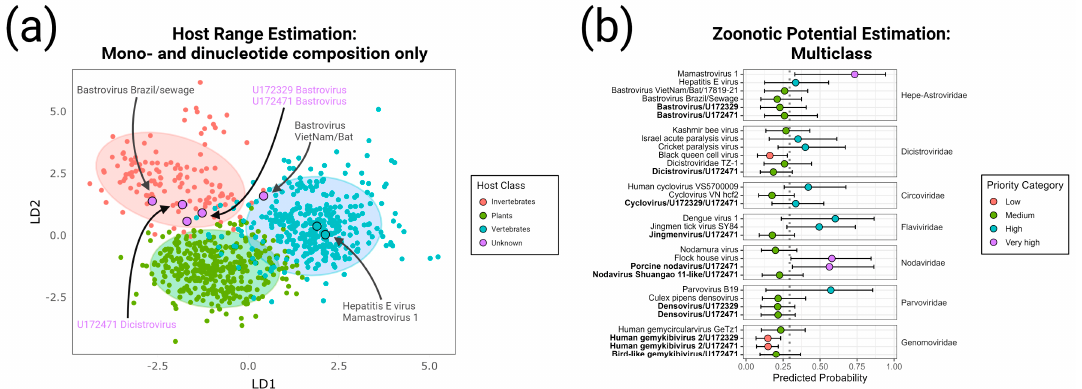
Figure 5. Assignment of host class and zoonotic potential. ( a ) The canonical score plot of a linear discriminant analysis used to classify picorna-like viral sequences into three host groups using all 4 mononucleotide and all 16 dinucleotide frequencies. The plot shows the separation of host groups through the two most statistically significant factors. The training dataset with known host range (n = 945 genomes) was used to establish a scoring profile such that the viral sequences with unknown host could be classified. The ellipses represent the 90% confidence level (i.e., 90% of sequences fitting a host range group fit inside the ellipsis) centered on the centroid of each group. Sequences from the bastroviruses from U172329 and U172471, the dicistrovirus from U172471, and four comparator sequences are labeled separately. ( b ) Predicted probability of human infectability for all novel viruses identified in this study and closely related comparator sequences. Dots show the mean and bars show the 95% interquartile range of predicted probabilities across the best-performing 10% of iterations. The cut-off for zoonotic potential was set at 0.293 with priority categories assigned as previously described [49]: low: mean and upper/lower interquartile ranges below cutoff; medium: mean below cutoff but upper interquartile range above cutoff; high: mean above cutoff but lower interquartile range below cutoff; very high—mean and upper/lower interquartile ranges above cutoff. In both panels, the dicistrovirus recovered from specimen U172329 was not analyzed due to its low (45%) total